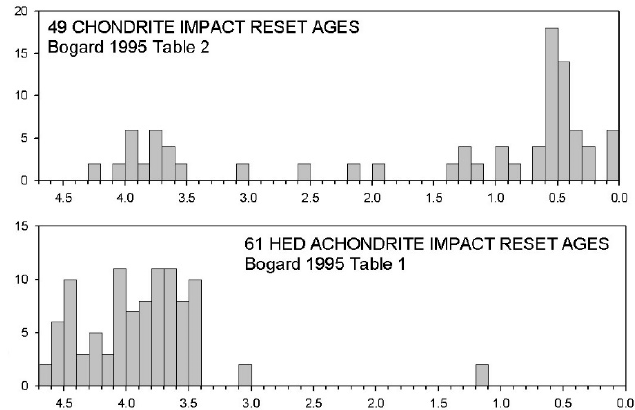
Figure 11. Age distributions of asteroidal meteorite ages for 49 chondrite and 61 HED achondrite ages, reported by Bogard (1995 [114]). The data show no sharp spike at 4.0 to 3.8 Ga ago, but rather an extended impact history expending from ~4.5 or ~4.3 Ga ago to ~3.5 Ga ago. The spike in chondrite ages near 0.5 Ga ago is related to a now-known impact fragmentation or cratering event on the L chondrite parent body, dated at 470 Ma ago (Schmitz et al. 2003 [115]; Trieloff et al. 2006 [116]).